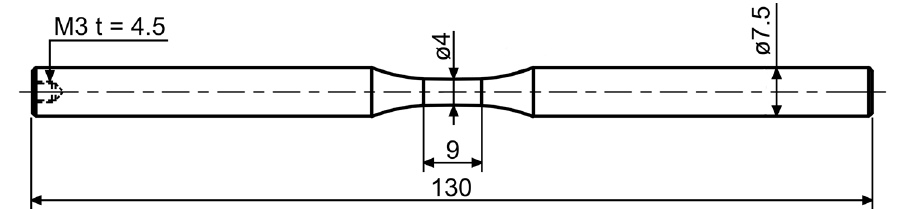
Figure 8. Specimen geometry for µ -computer tomography and immersion 8